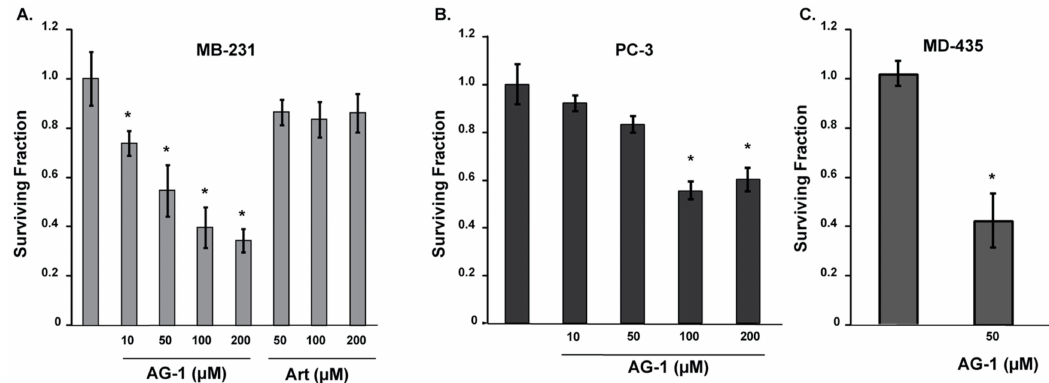
Figure 5. Artemisinin dimer (AG-1) treatment is more cytotoxic than Art. Asynchronous cultures of human ( A ) MB-231 breast cancer, ( B ) PC-3 prostate cancer and ( C ) MD-435 melanoma cancer cells were treated for 72 hours with Art or AG-1. Monolayer cultures were trypsinized and re-plated at limiting dilutions designed to plate single cells. Cultures were continued for 14 days in absence of the drugs. Cells were fixed and stained with crystal violet. Surviving fraction was calculated after correction for plating e ffi ciency. Results are presented as average and standard deviation. Asterisks represent significance compared to untreated control cells; n = 3, p < 0.05.